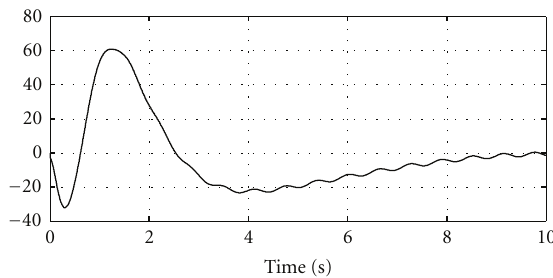
Figure 4: Control input for Example